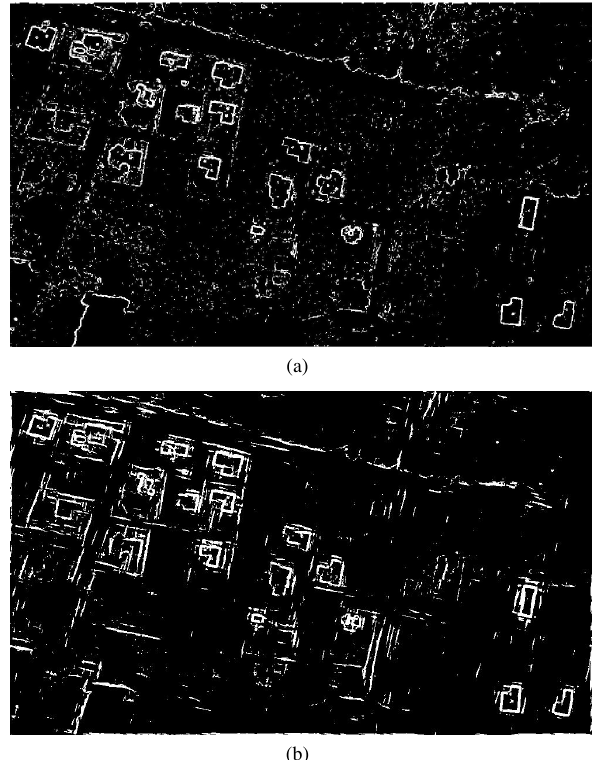
Figure 5: Comparing the edge maps for u ∗ channel : (a) shows shearlet based edge